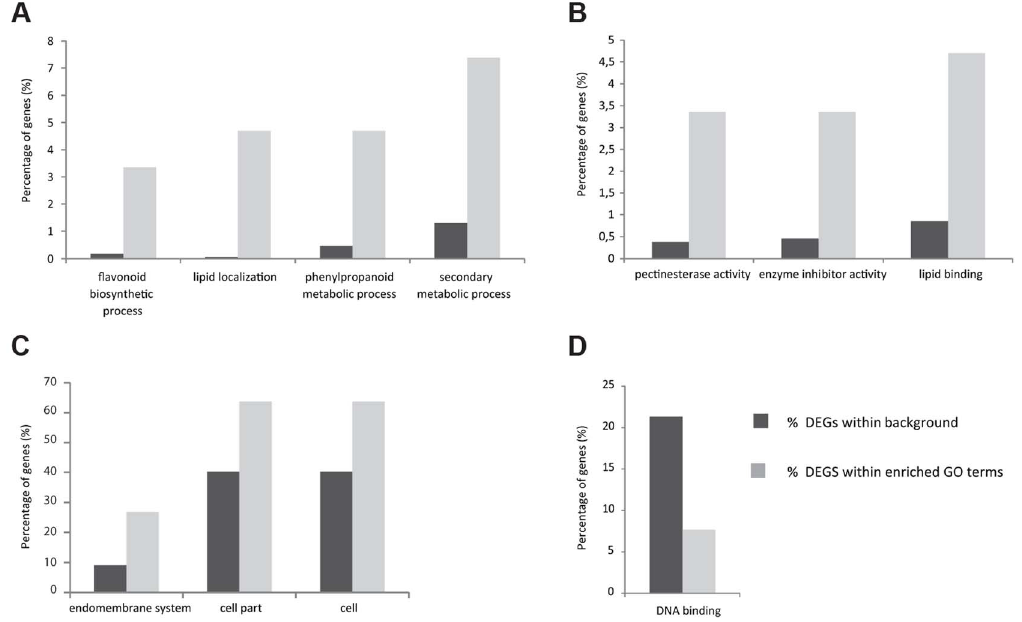
Fig. 1. Histogram of functional gene ontology analysis of differentially expressed genes. Slim Plant term enrichment - up and down- regulated genes. Genes with higher expression in stk in the Biological Process ( A ), Molecular Function ( B ) and Cellular Component ( C ) categories. Genes with lower expression in stk Molecular Function category ( D ).